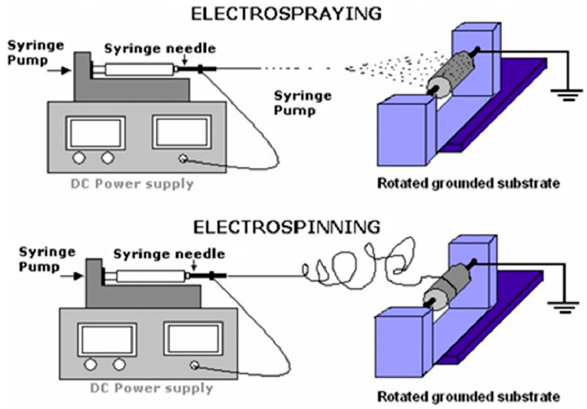
Figure 3. Electrospinning/electrospraying setup. Reprinted with permission from [26].